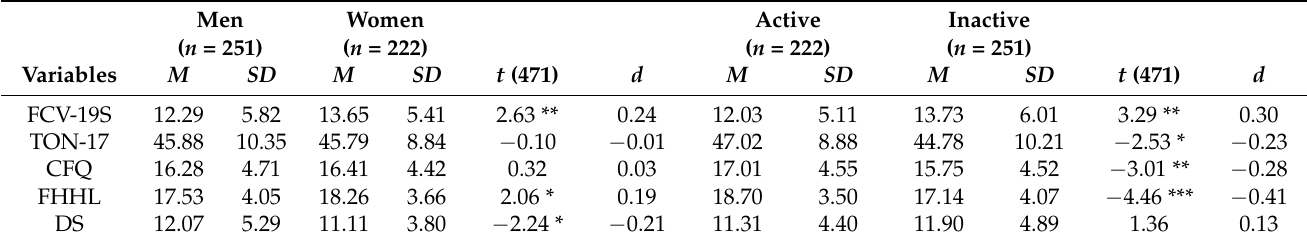
Table 3. Differences in orthorexia and fear of COVID between female and male participants and active and inactive people. Men Women